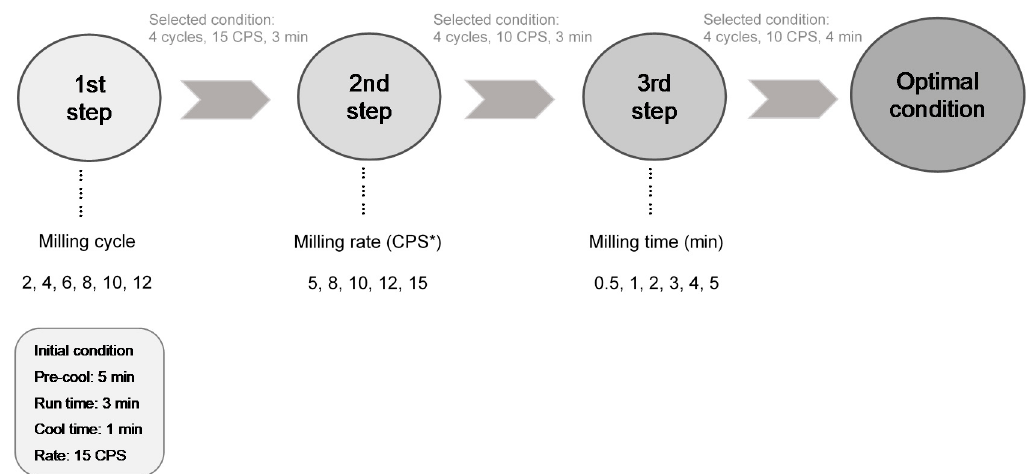
Figure 1. Cryogenic milling conditions for dried ginseng root. The condition of a cycle was 3 min milling at a rate of 15 CPS (cycles per second). CPS* indicates the number of back-and-forth cycles per second completed by the impactor.